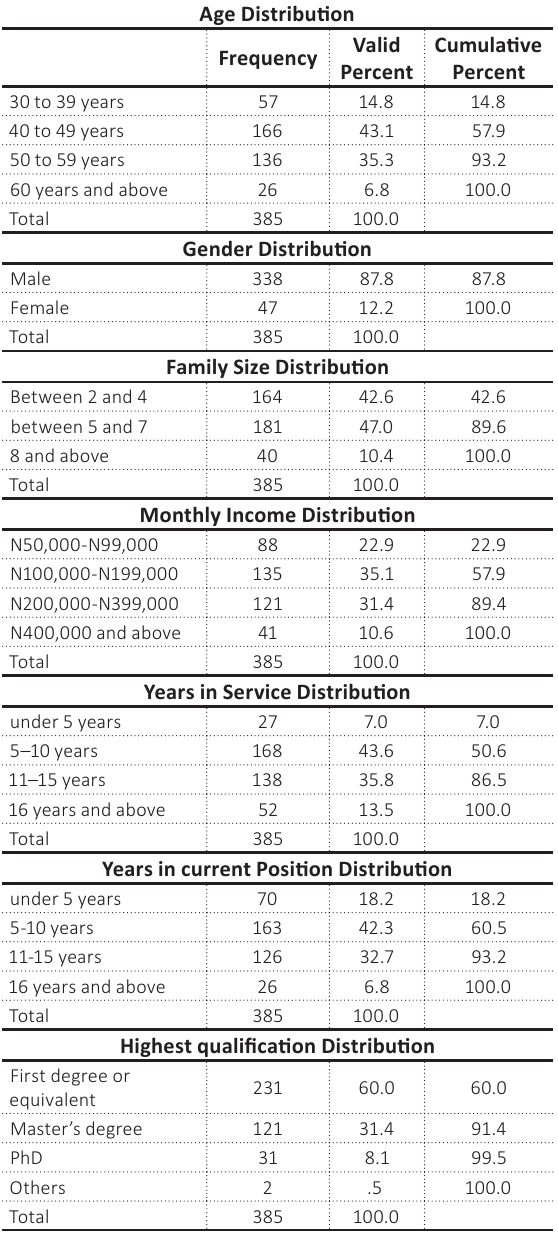
Source: Author’s computation,